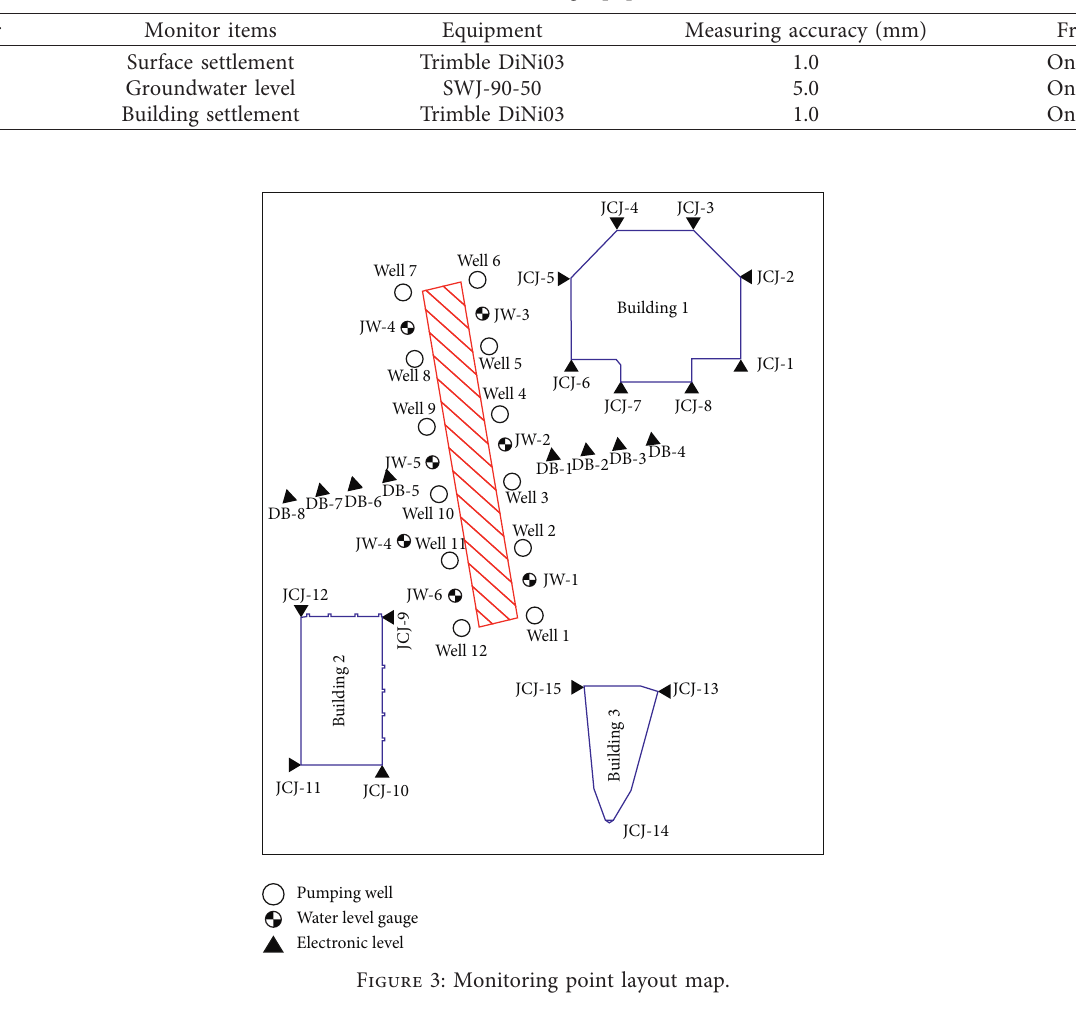
Table 1: Monitoring equipments.